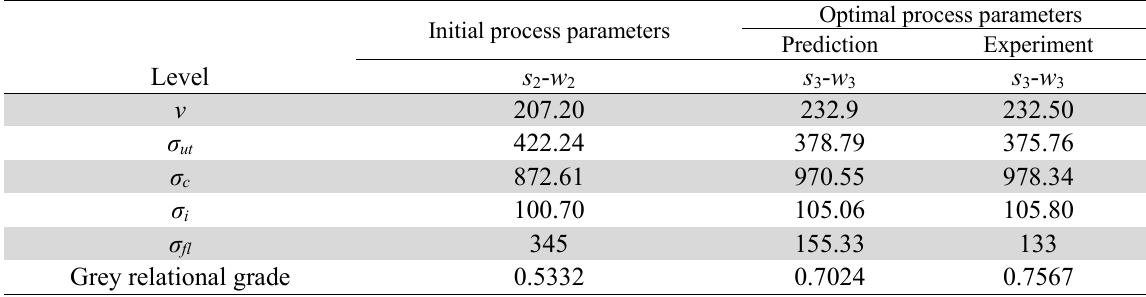
Results of confirmation experiments